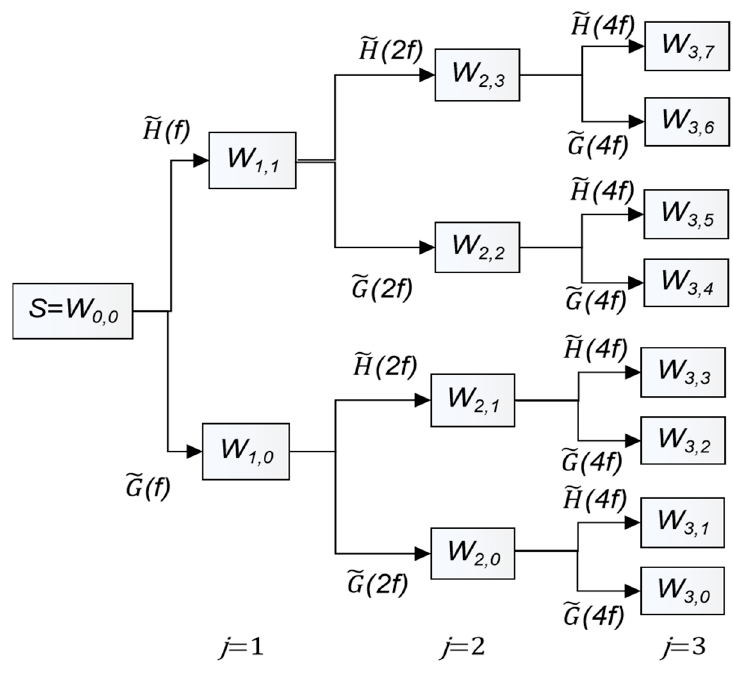
Figure 5. Full wavelet packet tree down to level 3.